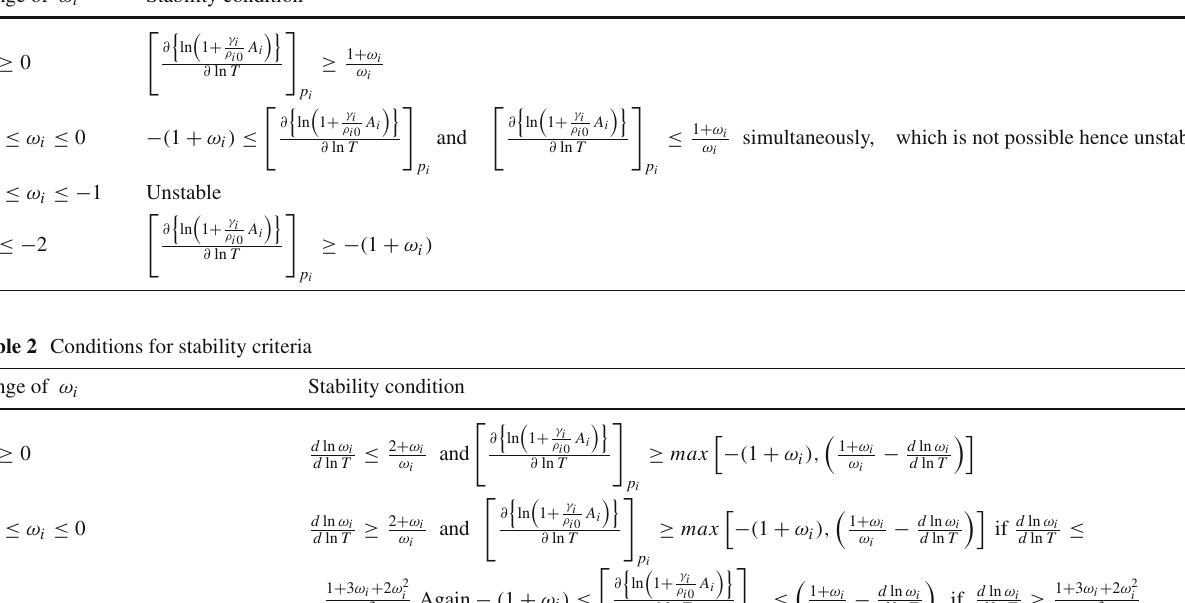
Table 1 Conditions for stability Range of ω i Stability condition